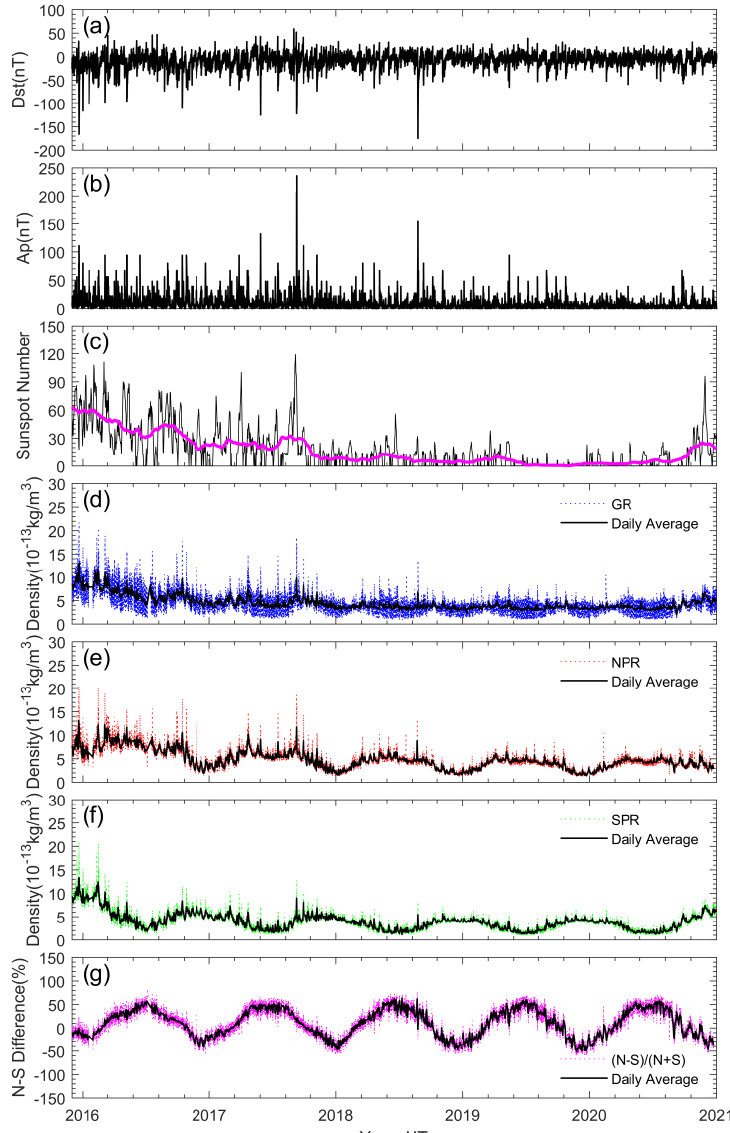
Figure 7. Geomagnetic index and density variations from December 2015 to December 2020: ( a ) Dst index, ( b ) Ap index, ( c ) sunspots—the magenta line is the monthly average value, ( d ) global region (GR) atmospheric density, ( e ) NPR atmospheric density, ( f ) SPR atmospheric density, ( g ) hemispherical density difference, where the black lines in ( c – e ) and ( f )represent the corresponding daily